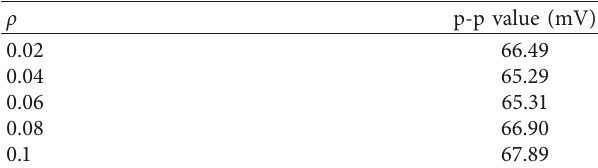
Figure 8: Comparison of time-domain signal with NNPID control on/off. Table 4: Comparison of vibration damping results with changing ρ